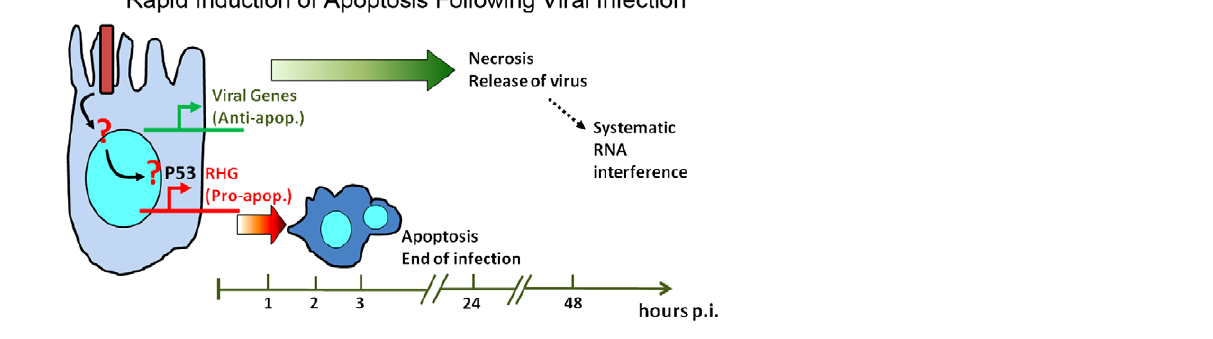
Figure 7. A diagram summarizing the role of rapid induction of apoptosis as an innate immune response against viral infection. By eliminating the infected cells before accumulation of viral gene products, the infection can be blocked at the initiation stage.